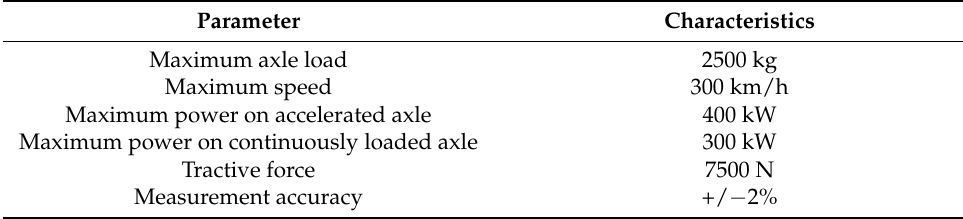
Table 2. Technical data of the roller dynamometer DF4FS-HLS.